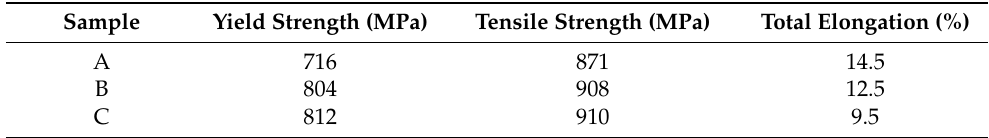
Table 2. Tensile properties of the three steel